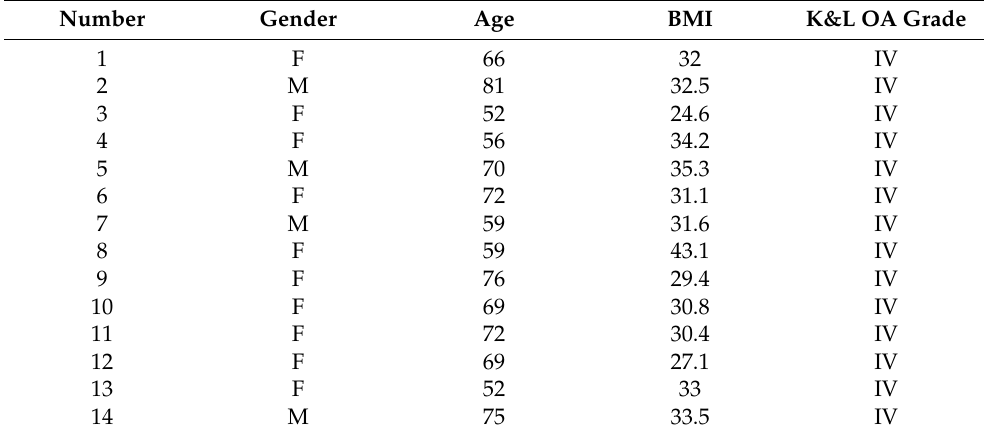
Table 1. Clinical and demographic data of the patients enrolled. Kellgren & Lawrence classification for osteoarthritis (K&L OA Grade)